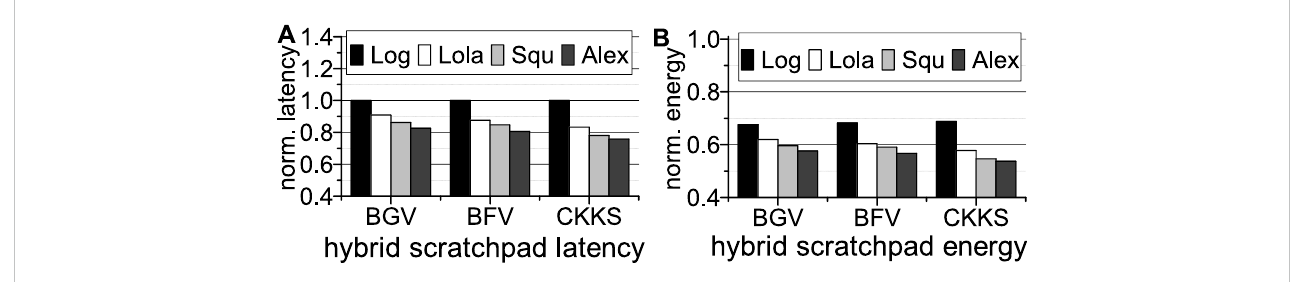
FIGURE 11 The inference latency and energy of BTS with a NAND-SPIN and SRAM hybrid scratchpad memory (A) : hybrid scratchpad latency; (B) : hybrid scratch energy; all are normalized to BTS with a 512 MB SRAM scratchpad memory.